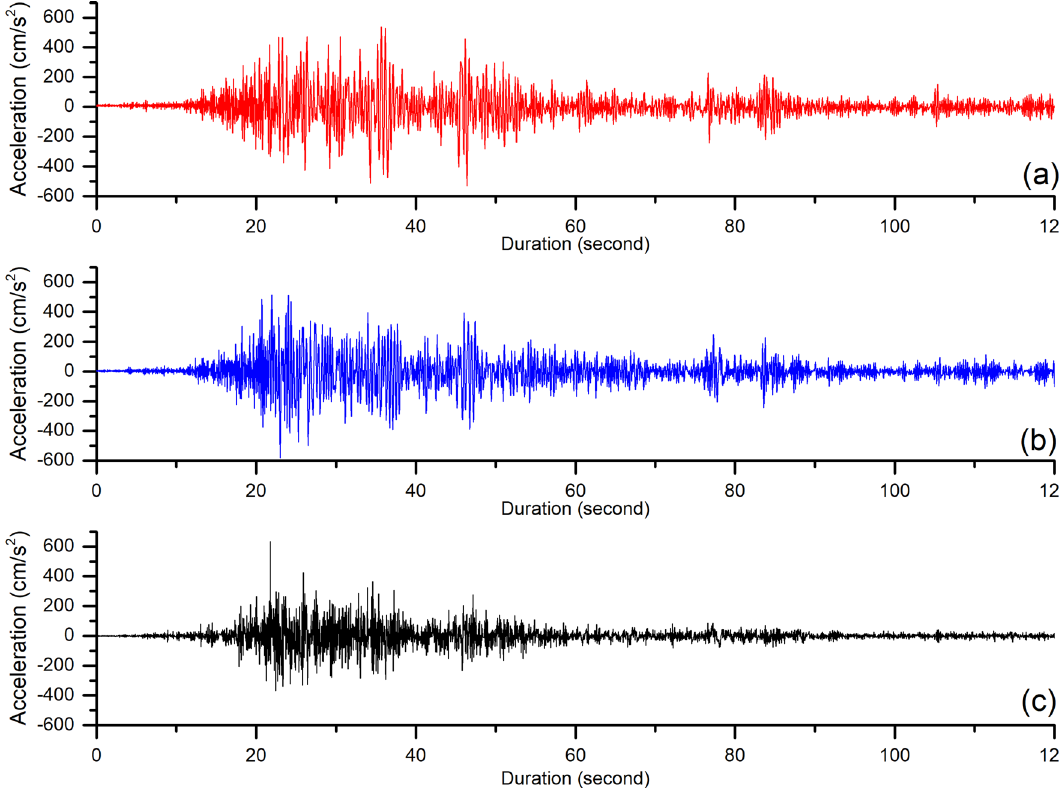
Figure 5. Acceleration-time curves of the Wenchuan seismic wave used in the model (Horizontal and vertical ground acceleration records of Bajiao town seismic station). ( a ) Horizontal: West–East component. Peak Ground Acceleration = 556.17 cm/s 2 ( b ) Horizontal: North–South component. Peak Ground Acceleration = -581.59 cm/s 2 ( c ) Vertical: UD component. Peak Ground Acceleration = 633.09 cm/s 2